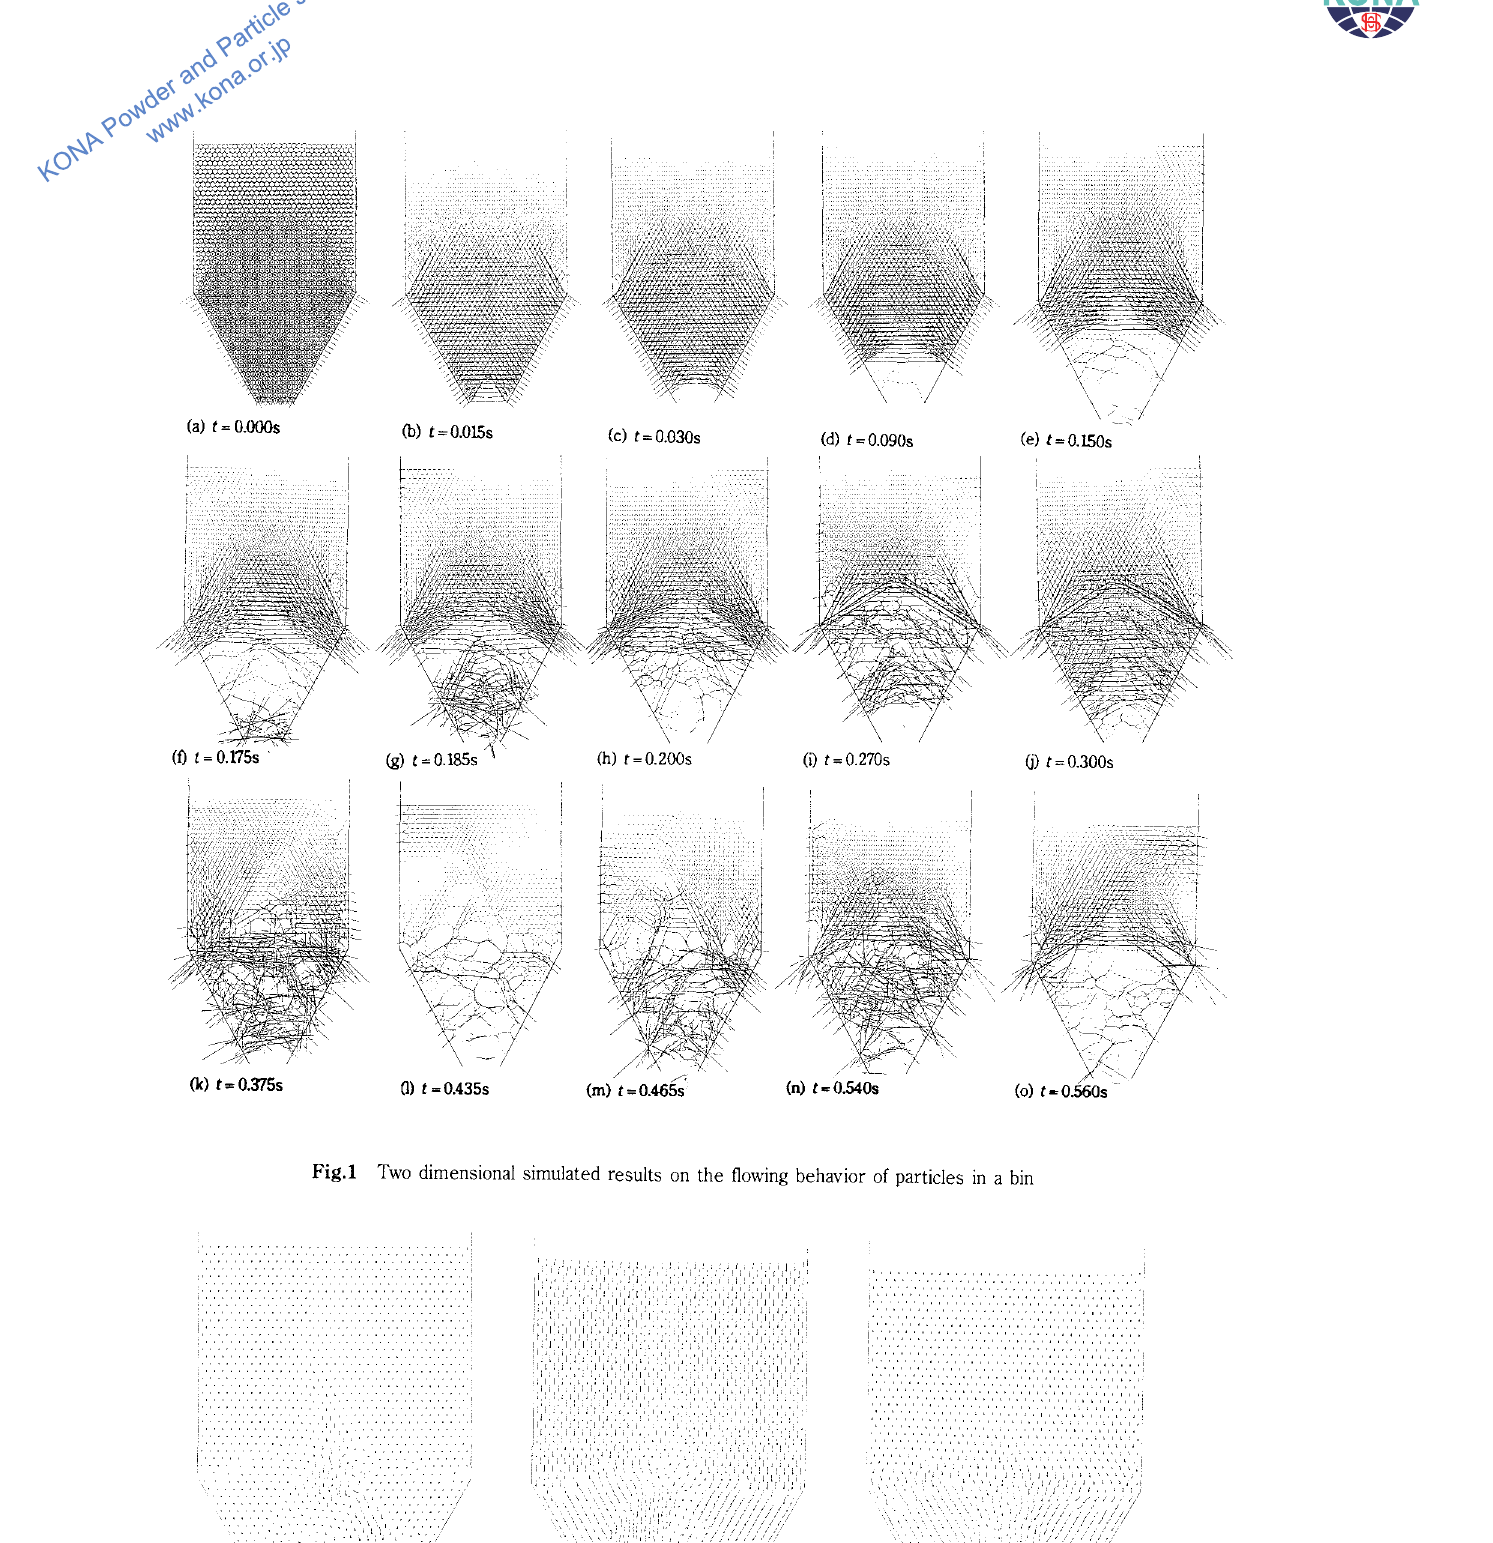
Fig.l Two dimensional simulated results on the flowing behavior of particles in a bin